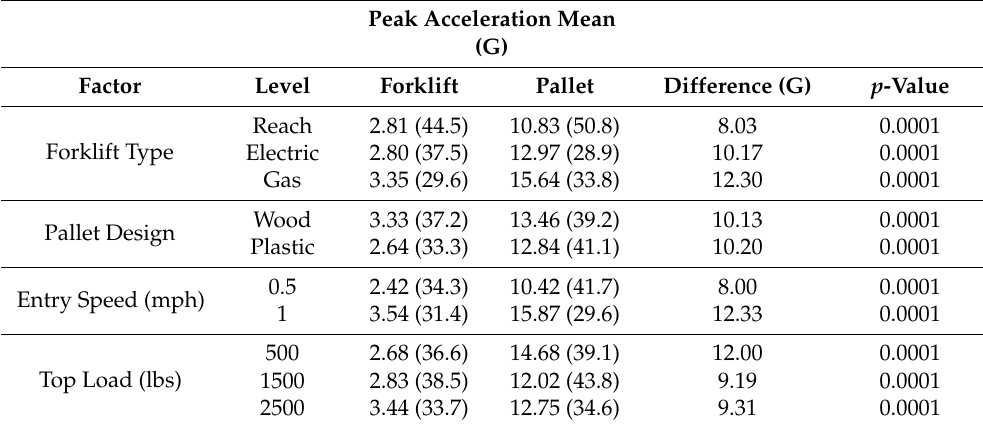
Table 6. T Pairwise Comparisons for Peak Acceleration Mean: Pallet vs Forklift